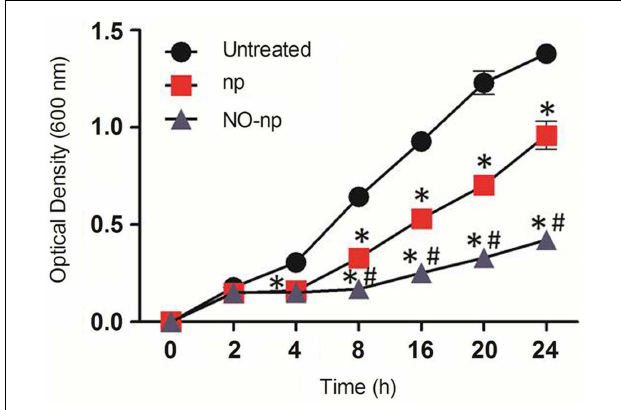
FIGURE 1 |The effect of NO-np on C. albicans growth kinetics was determined using Bioscreen C analysis. C. albicans was grown in the absence (untreated) or presence of nanoparticles with NO (NO-np) or without NO (np). Each point represents the average of three measurements. * P < 0.001 in comparing the np- or NO-np-treated group with untreated group. # P < 0.001 in comparing the np-treated group with the NO-np-treated group.This experiment was performed twice, with similar results each